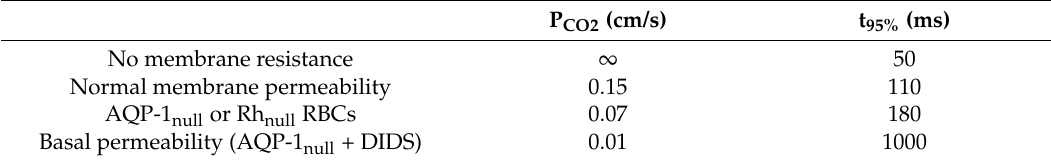
Basal permeability (AQP-1 null + DIDS) 0.01